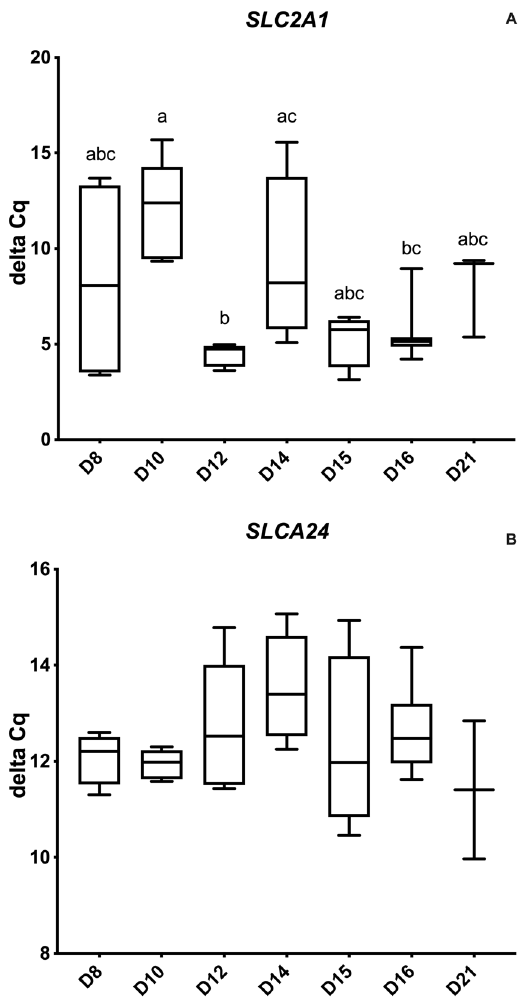
Figure 5. Relative abundance (delta Ct) of glucose transporter genes by embryonic age (Days 8 to 21 post- ovulation); ( A ) Glucose transporter protein type 1 (GLUT1) (SCL2A1) and ( B ) Glucose transporter protein type 4 (GLUT4) (SCL2A4). Delta Ct concentrations have an inverse relationship to mRNA abundance. Differences between days ( p < 0.05) are indicated by different superscripted letters.